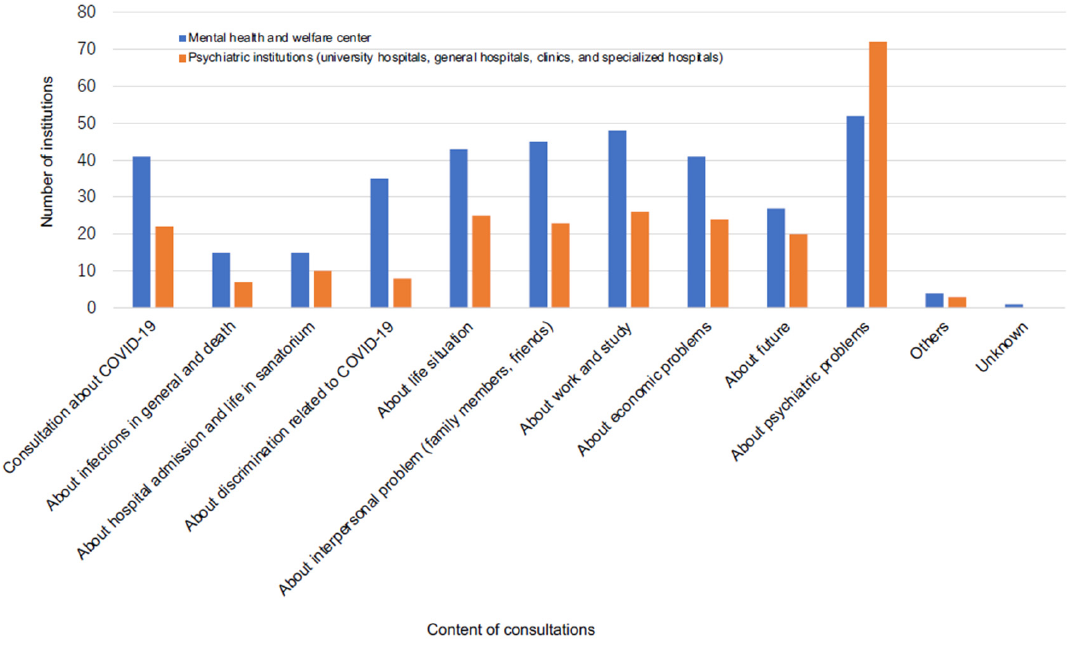
Figure 5. Number of consultations according to